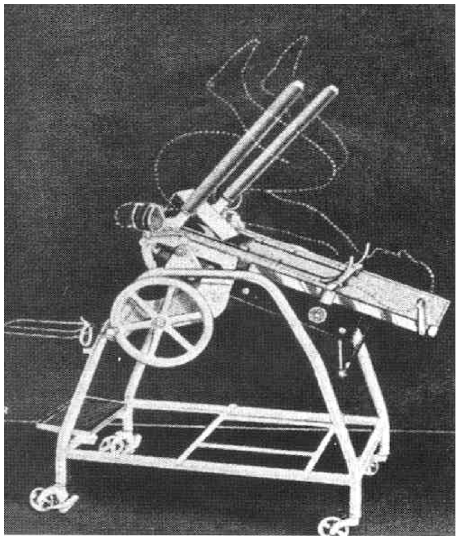
Figure 2 – The Young retractor which is still used today for the perineal